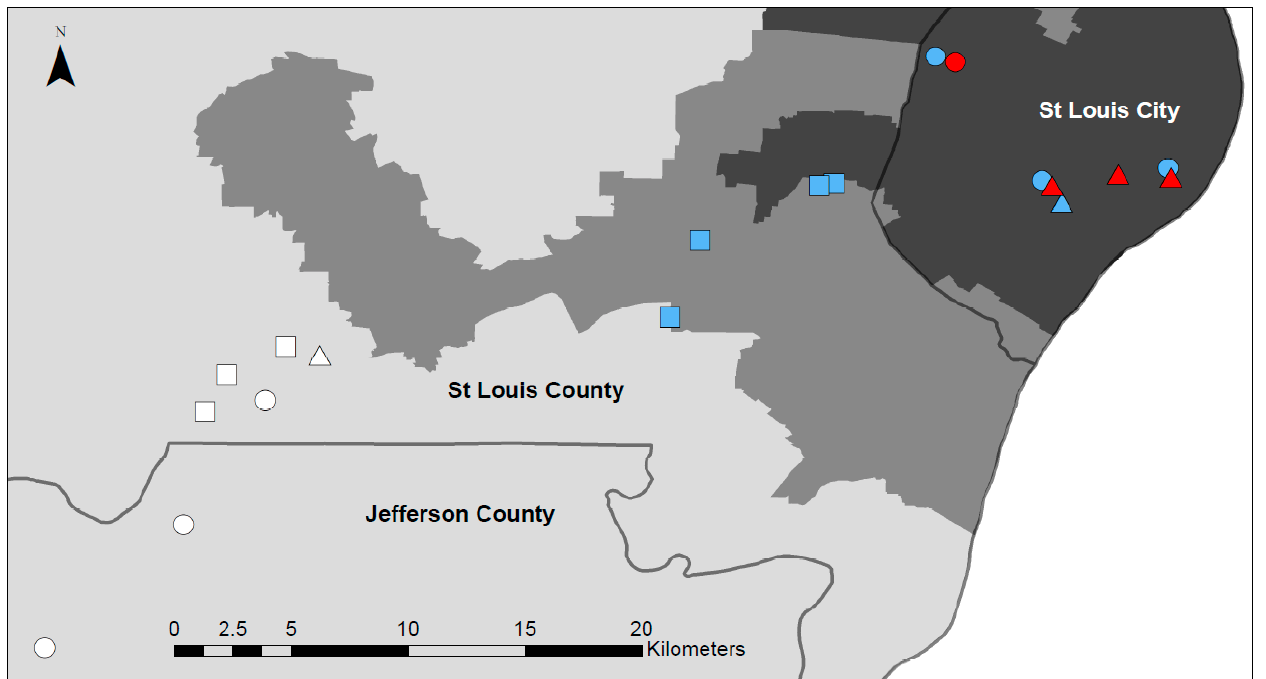
Figure 1. Mosquito sampling sites by habitat type. Rural: light grey, Suburban: Medium grey, Urban: dark grey. Squares: site was sampled in both years, Circle: site was sampled in 2017, Triangle: site was sampled in 2018. The color of the icons denote the percent impervious for each site at a 30 m 2 scale (data obtained from the Multi-Resolution Land Characteristics Consortium). White: <5%, Blue: 5–55%, Red: >55%. County boundaries indicated with dark grey lines.